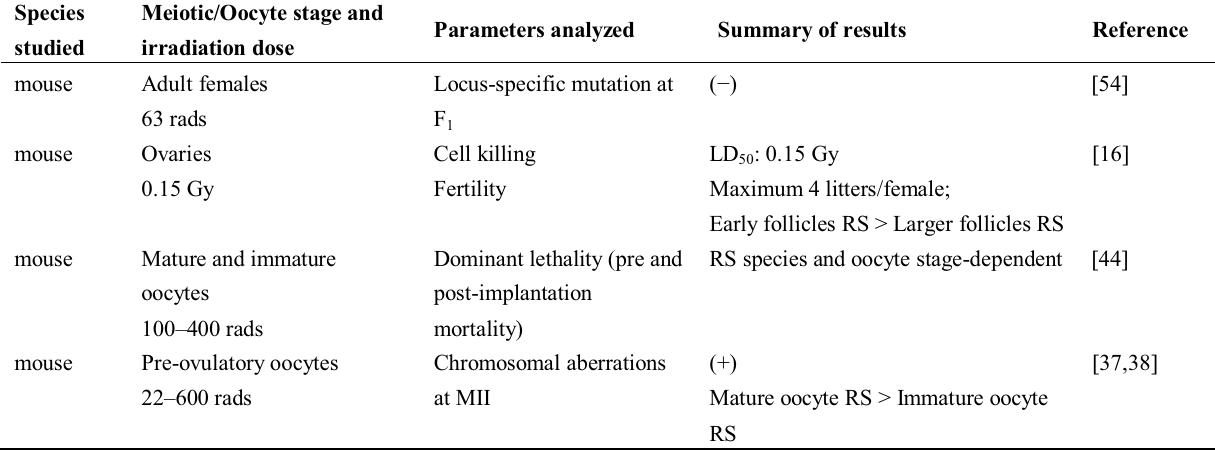
Table 1. Summary of the results of genotoxic effects of ionizing irradiation on experimental